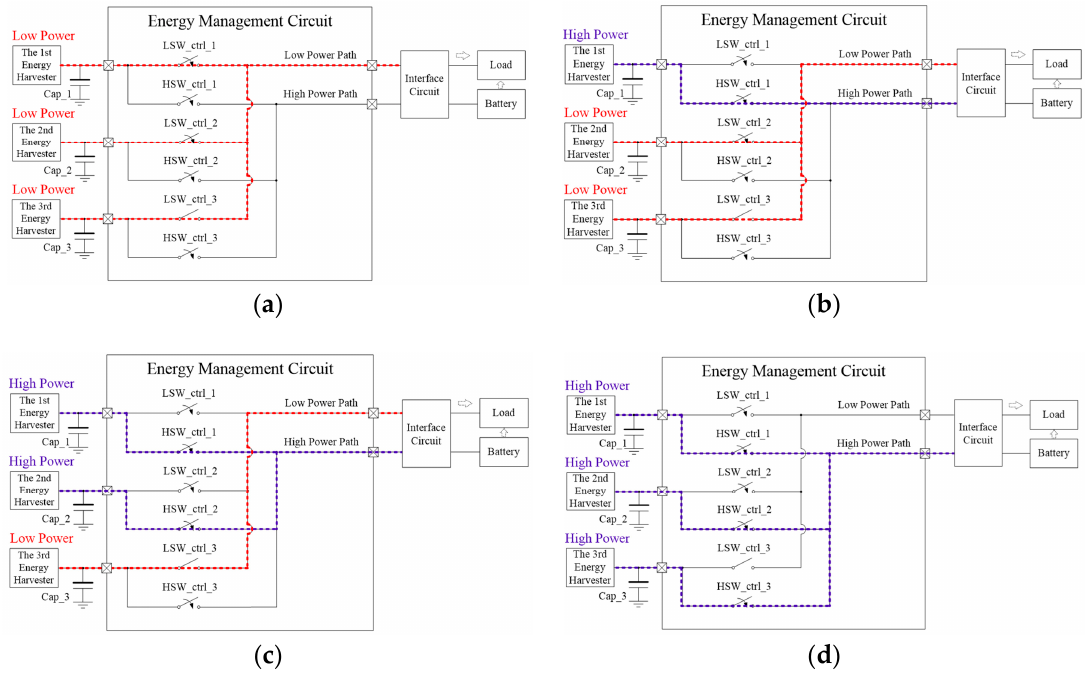
Figure 4. Energy flow according to the magnitude of energy harvested in the proposed energy management circuit. ( a ) 3 low powers; ( b ) 2 low powers and 1 high power; ( c ) 1 low power and 2 high powers; ( d ) 3 high powers.